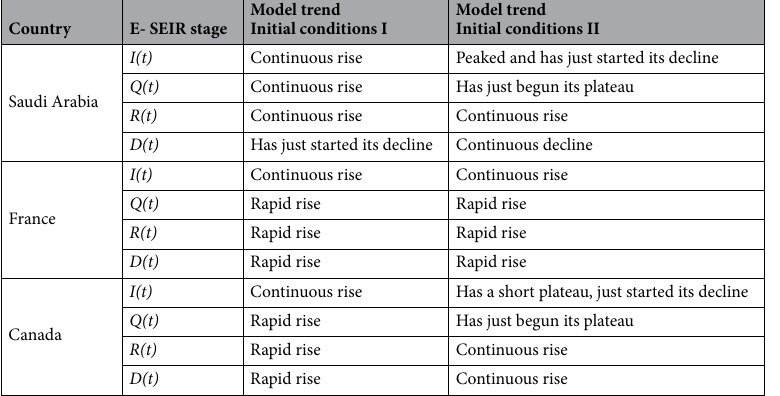
Country E- SEIR stage